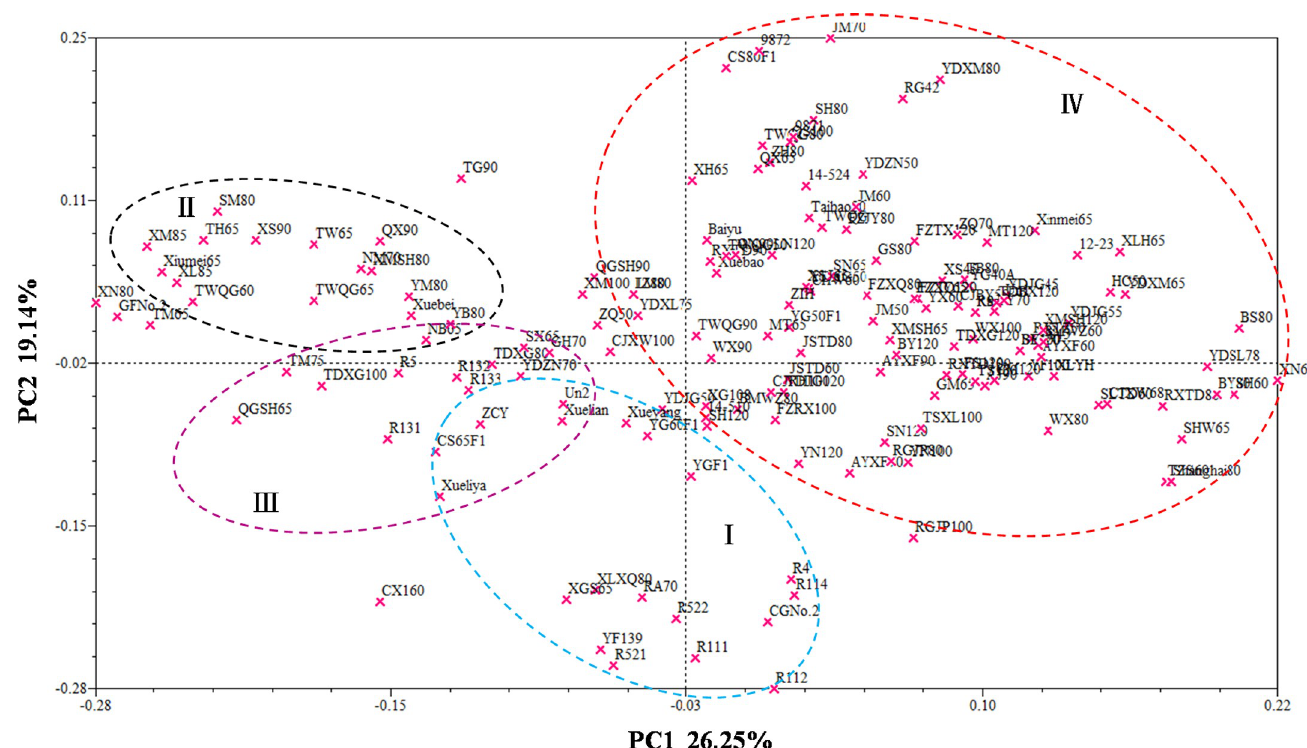
Fig 4. Associations among the 165 cauliflower inbred lines revealed by principal coordinate analysis (PCA) performed on Nei’s genetic distance matrix data calculated from 43 SSR markers.